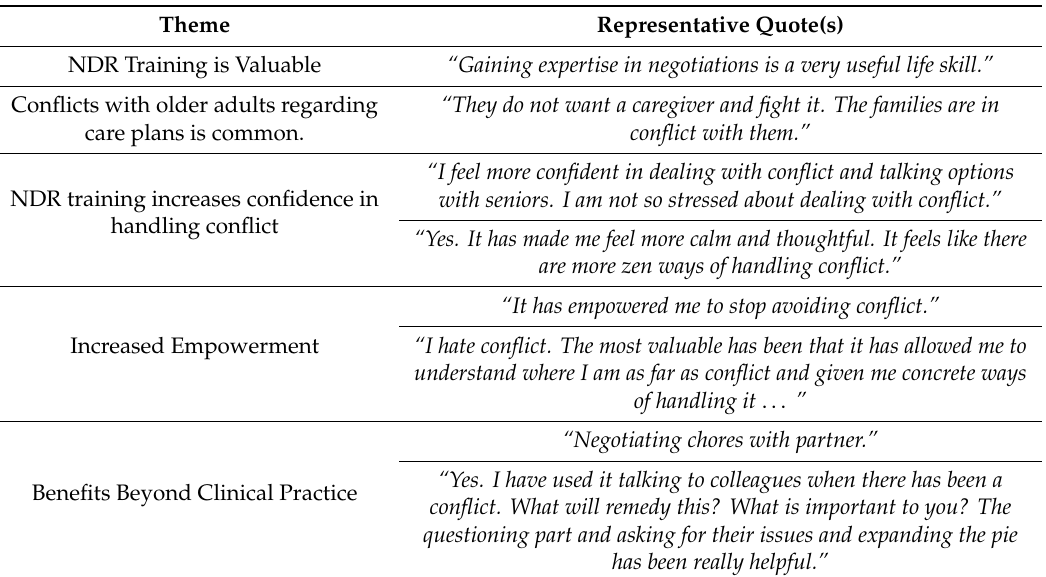
Table 2. Themes resulting from post NDR training